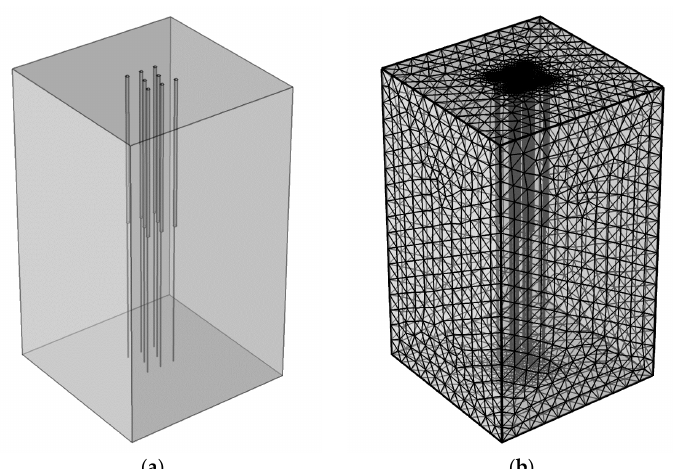
Figure 7. ( a ) The geometry model, ( b ) The mesh distribution of quincuncial arrangement.